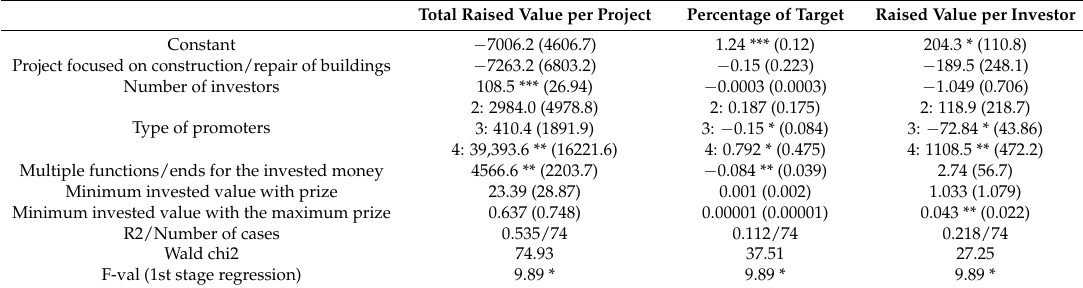
Table 6. Type of Project: Entrepreneurship. Estimations for total funded value, percentage of target, and value per investor